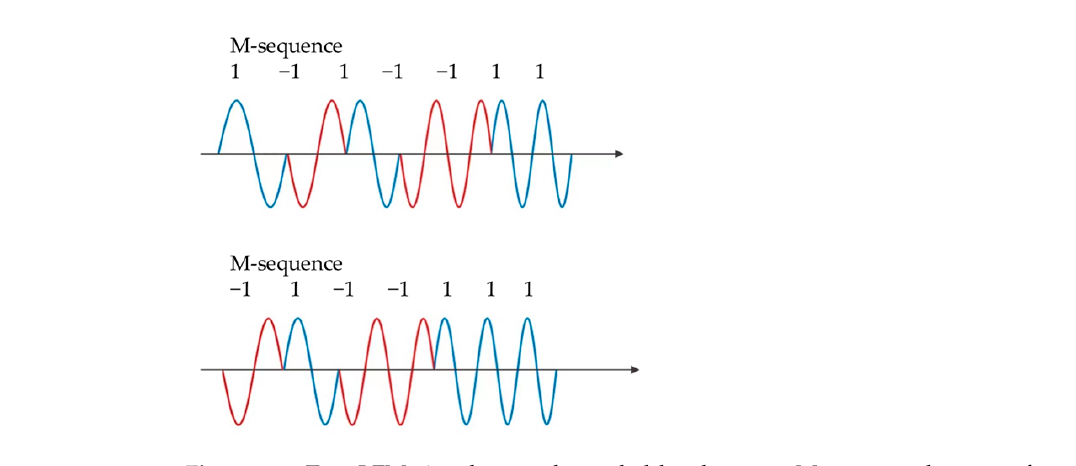
Figure 20. Two LFM signal examples coded by the same M-sequence but start from different sequence indexes.